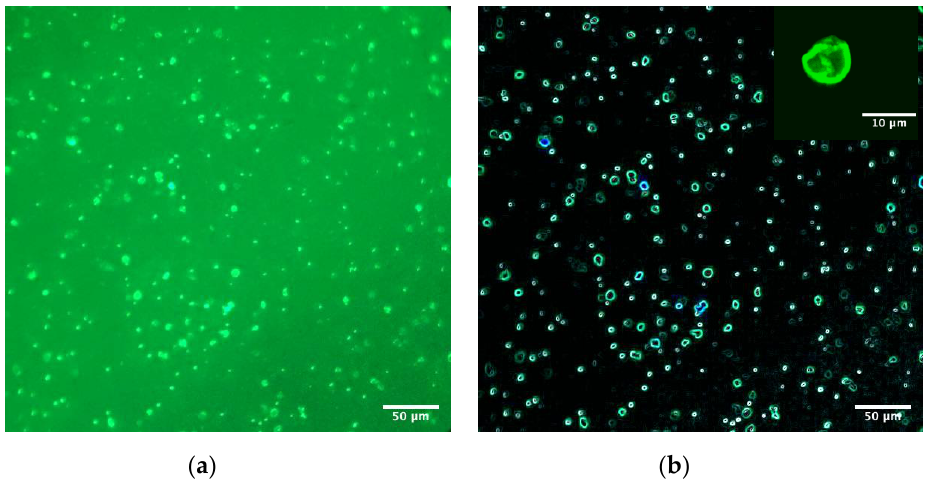
Figure 16. ( a ) Bright field and ( b ) dark field confocal image of erythrocytes ghosts with AuNPs-FI.